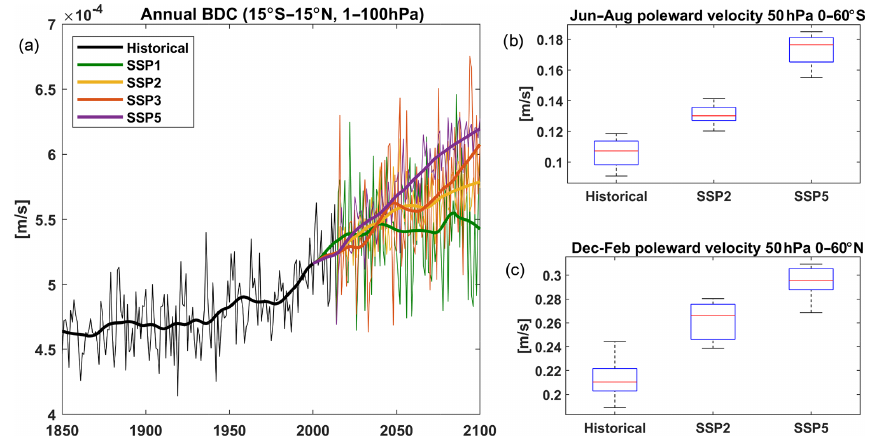
Figure 7. (a) The time series of the annual Brewer–Dobson circulation (vertical residual circulation speed at 15 ◦ S–15 ◦ N; 1–100hPa). Colours represent the same simulations as in Fig. 1. Boxplot of Southern Hemisphere (b) and Northern Hemisphere (c) meridional residual circulation speed during local winter at 50hPa. Data for the historical period in the boxplot are for an average from 2004 to 2014 and for SSP periods between 2090 and 2100. Red lines represent the median, blue boxes represent 25th–75th percentiles and dotted grey lines the total